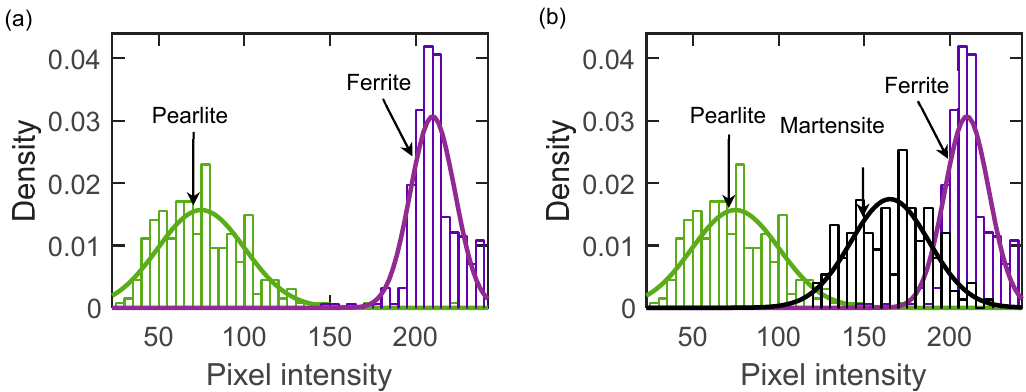
Figure 1. Probability density function of pixel intensities of metallurgical phases: ( a ) well-discriminated ferrite and pearlite phases, and ( b ) overlapped ferrite, pearlite, and martensite phases.